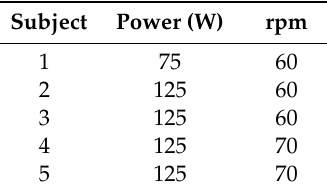
Table 4. Submaximal test loadings.